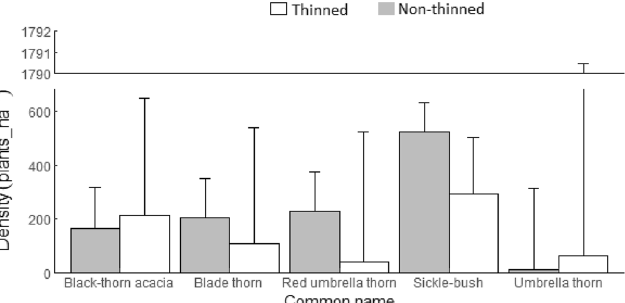
Figure 2. Expected number of tree/shrub densities (plants ha −1 ) in the thinned and non-thinned treatment areas estimated from the generalized linear mixed-effects model (GLMM) coefficients. Error bars indicate ± 95% confidence level of the variability in tree/shrub